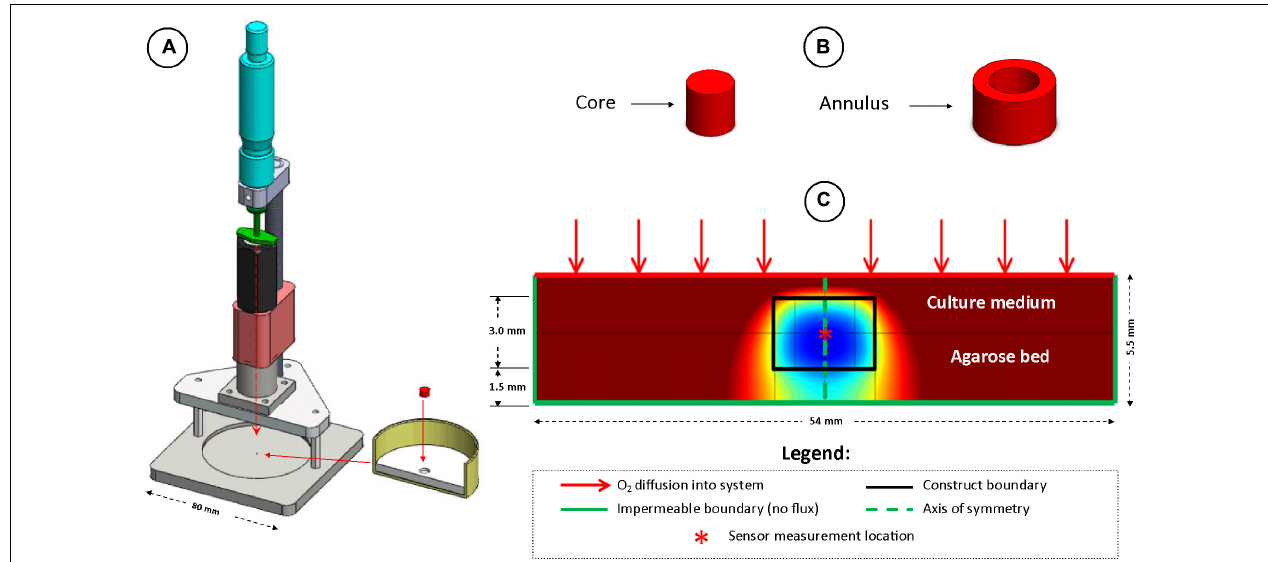
FIGURE 2 | The local oxygen concentration in the center of in vitro engineered cartilage tissue grafts cultured in chondrogenic media was measured using a custom designed oxygen testing rig, test dish and fiber optic sensor (A) . Samples were separated into cores and annuli for spatial biochemical analysis (B) . Schematic of the finite element model developed to predict oxygen concentration gradients throughout constructs (C)